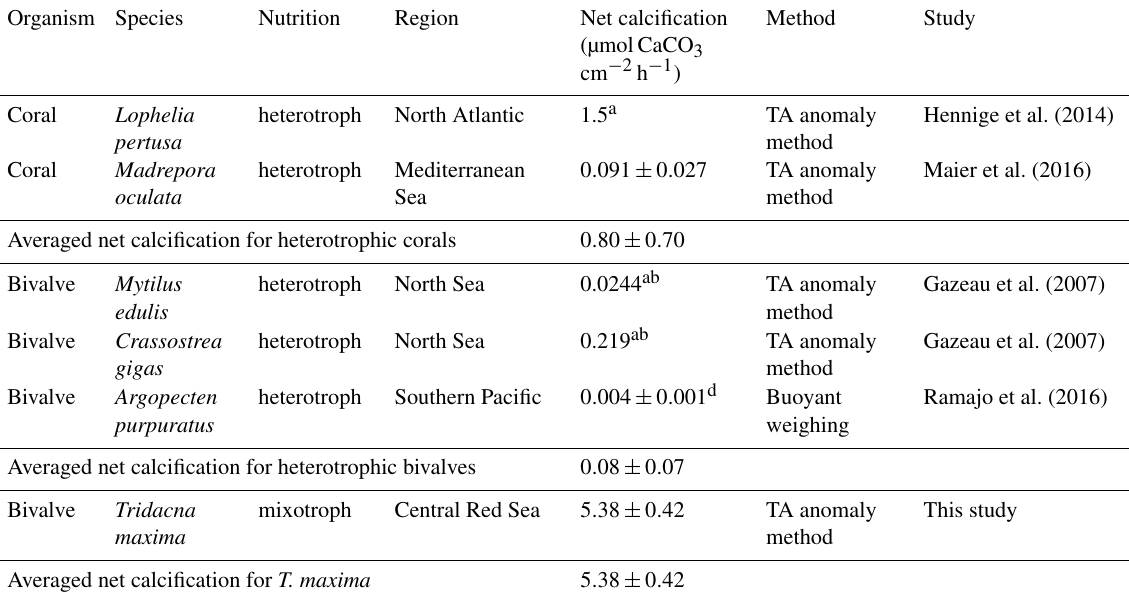
− 1 h − 1 from 3 gDM